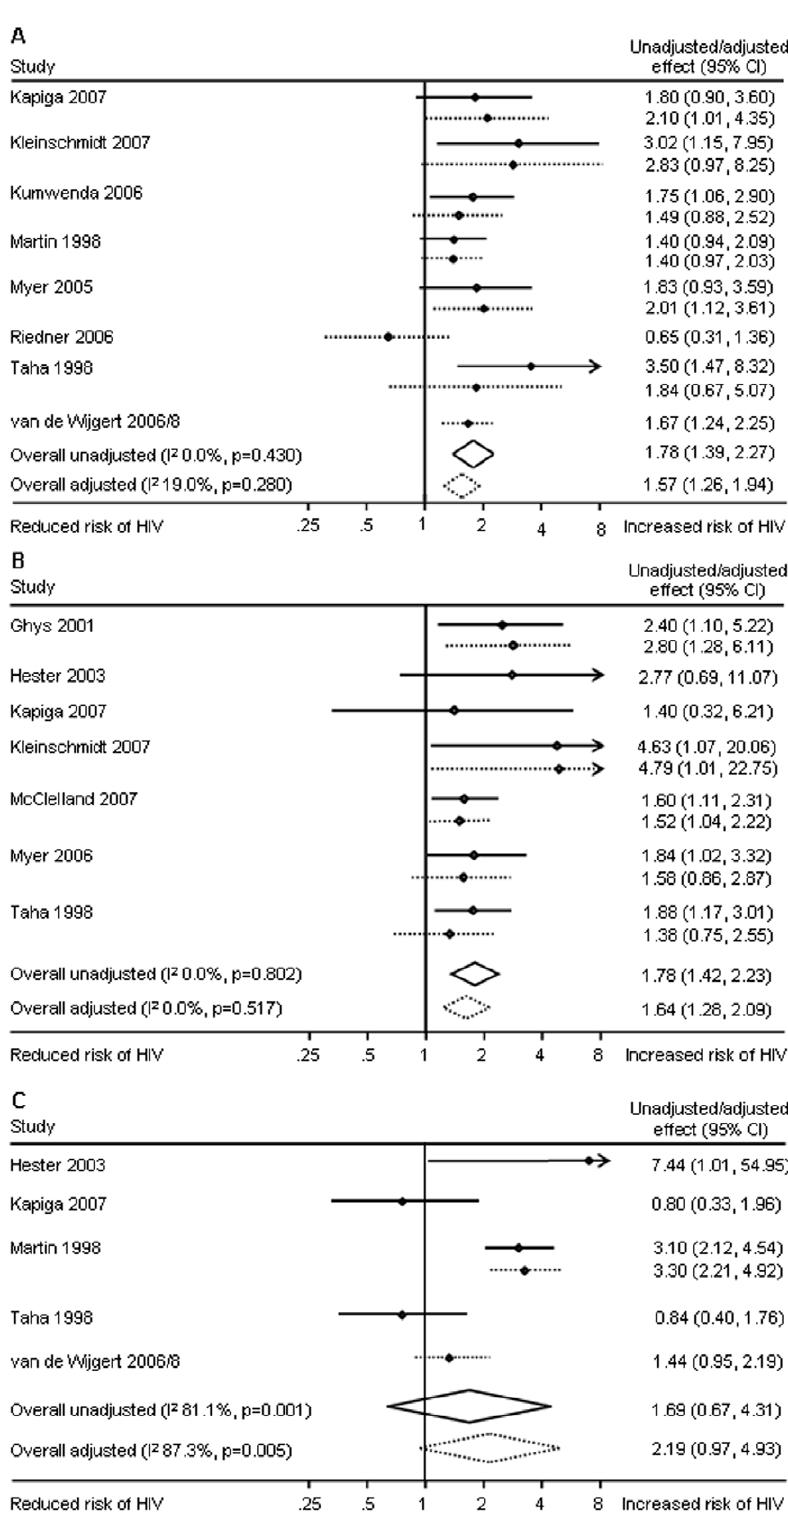
Figure 4. Meta-analyses of studies reporting associations between vaginal infections and HIV, unadjusted and adjusted effect estimates. Panel A: Bacterial vaginosis is associated with incident HIV infection. Eight studies contribute to the pooled adjusted effect estimate with little between study heterogeneity. Panel B: Trichomonas vaginalis infection is associated with incident HIV infection. Five studies contribute to the pooled adjusted effect estimate with no between study heterogeneity. Panel C: Candida or other yeast infections are not consistently associated with incident HIV infection. Two studies, with differing results contribute to the pooled adjusted effect estimate. Minor differences between effect estimates in the table and those in published papers are possible.